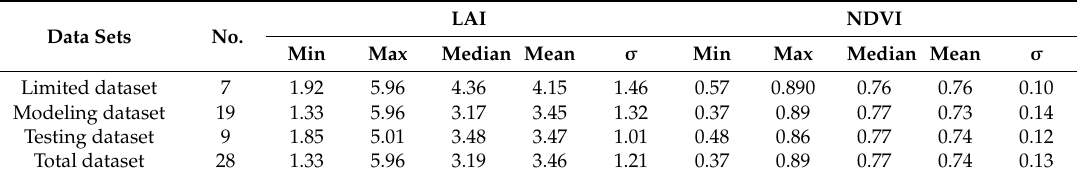
Table 4. Statistics of the LAI and normalized difference vegetation index (NDVI) in the limited, modeling, and testing dataset, compared with the total collected dataset in the study area. Data Sets